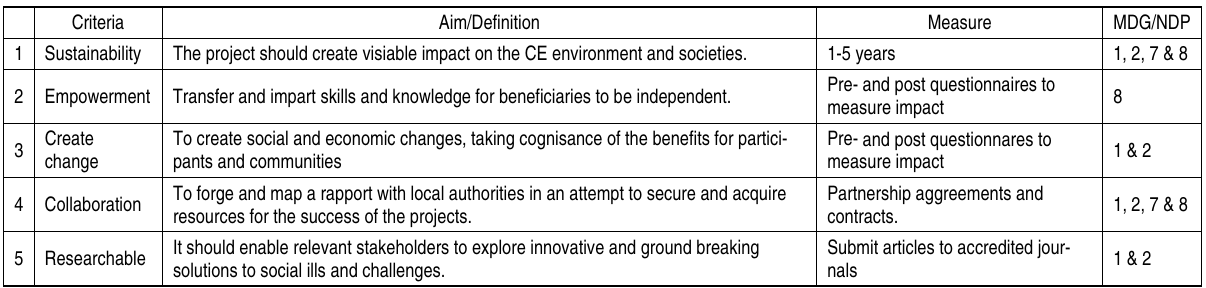
Table 2. Purpose of impact as